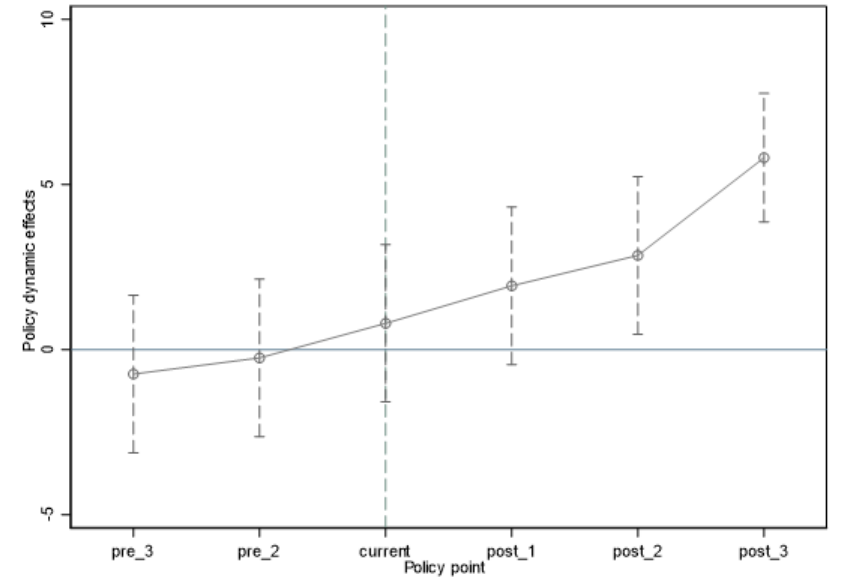
Figure 4. Dynamic effect diagram of parallel trend of PSM-DID mode l.